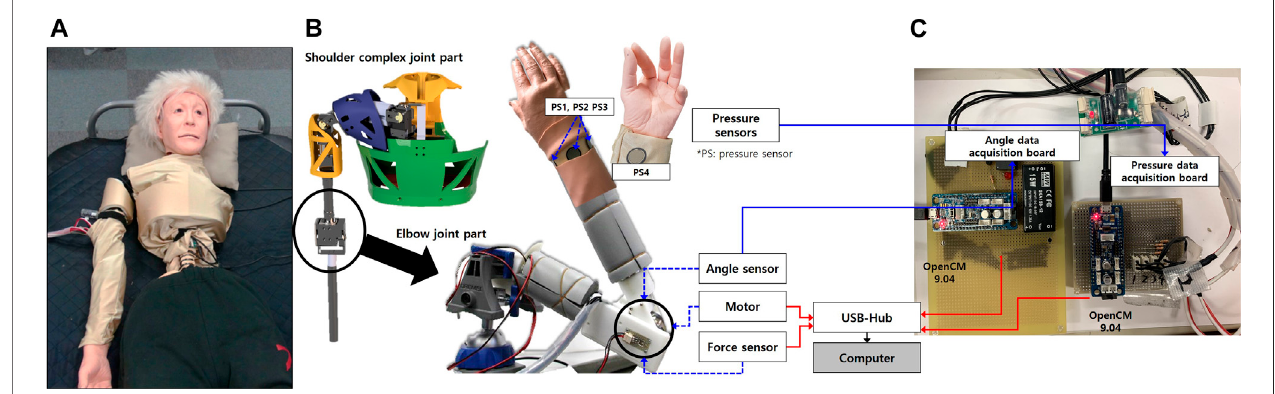
FIGURE 2 | Care training assistant robot (CaTARo): (A) prototype of the upper limb, (B) 3D modeling of upper limb, and (C) hardware con fi guration of the elbow part.